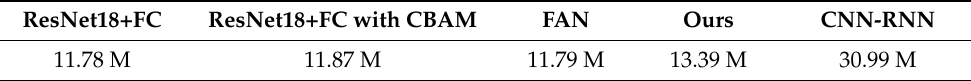
Figure 9. Comparison of the original data in the dataset before and after using applied spatial attention weights. The images are overlaid with a soft mask based on the values of the spatial attention matrix to demonstrate the role of spatial attention in capturing facial action regions. Table 3. Comparison of the number of parameters for different FER methods, including ResNet18+FC (baseline), ResNet18+FC with CBAM, FAN, CNN-RNN, and our proposed